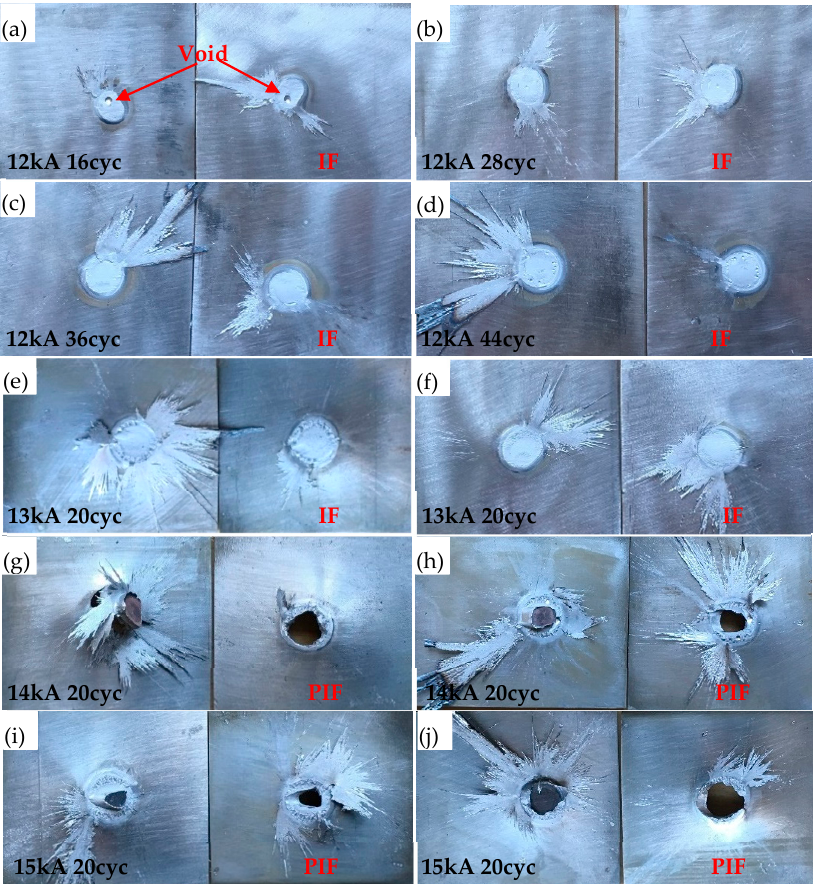
Figure 11. Failed tensile-shear samples under various welding parameters: ( a ) 12 kA, 16 cyc; ( b ) 12 kA, 28 cyc; ( c ) 12 kA, 36 cyc; ( d ) 12 kA, 44 cyc; ( e ) 13 kA, 20 cyc; ( f ) 13 kA, 20 cyc; ( g ) 14 kA, 20 cyc; ( h ) 14 kA, 20 cyc; ( i ) 15 kA, 20 cyc; ( j ) 15 kA, 20 cyc. IF: interfacial failure; PIF: partial interfacial failure. Metals 2018 , 8 , 48